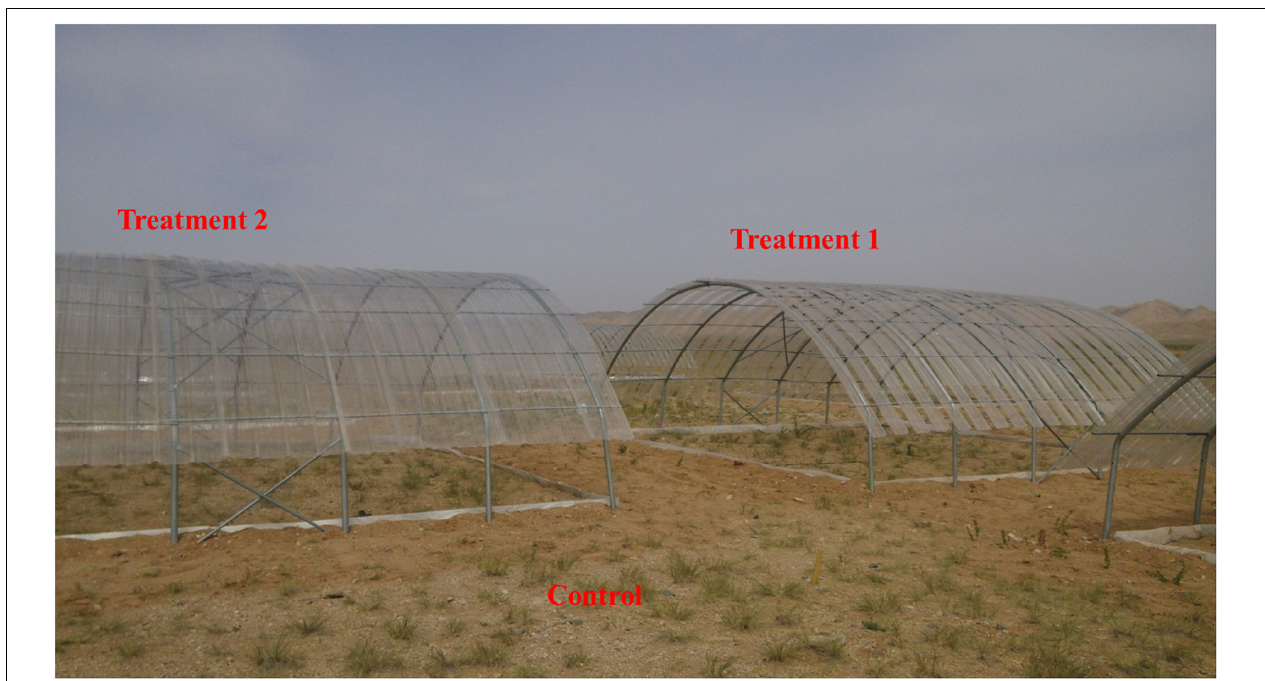
FIGURE 2 | Experimental platform for studying the response of ecosystems to extreme